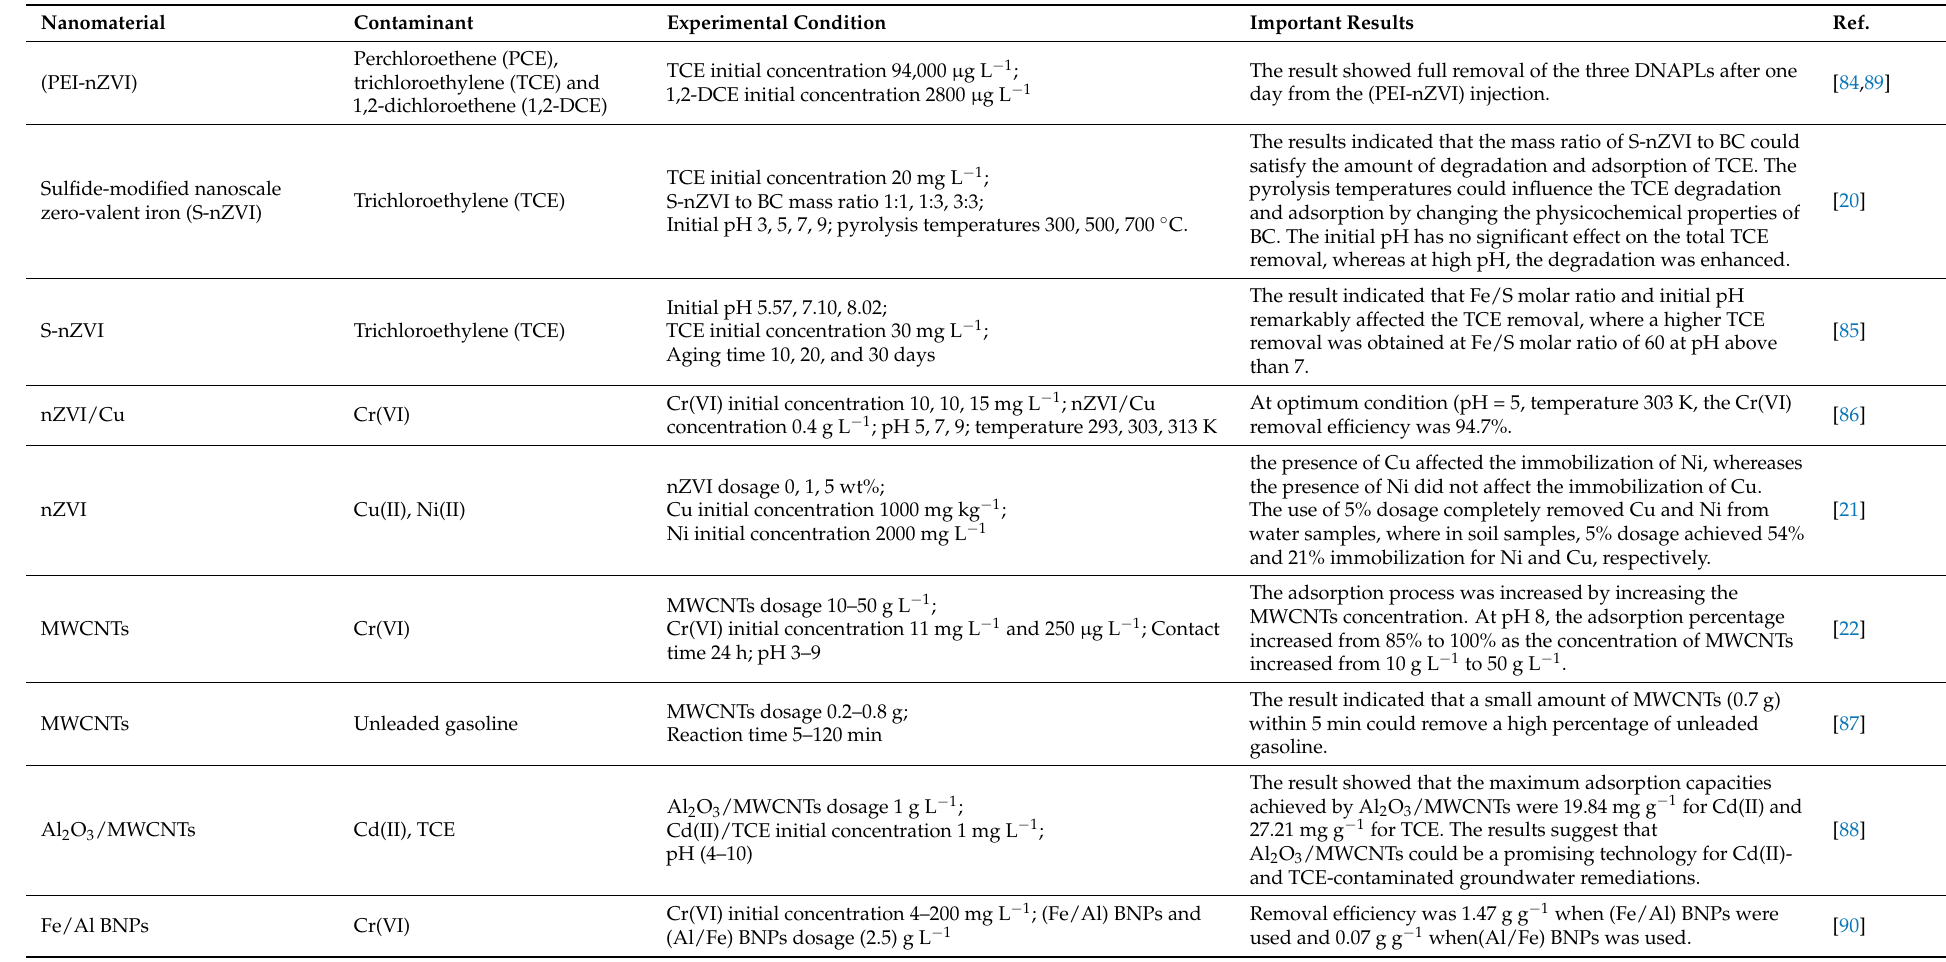
Table 2. Recent studies that employed nanoremediation methods for water and groundwater